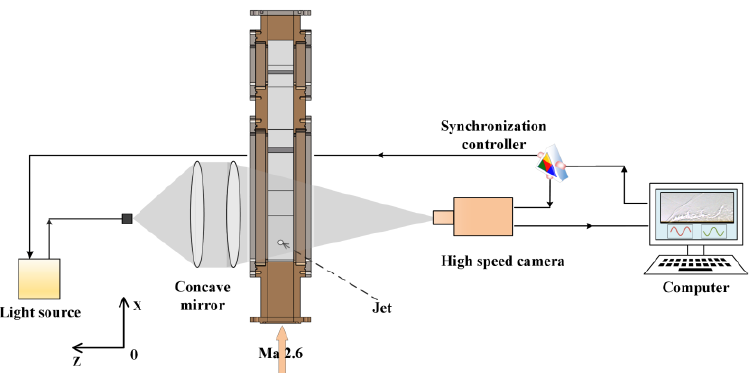
Figure 5. Setup developed to observe the flow field during the experiment.